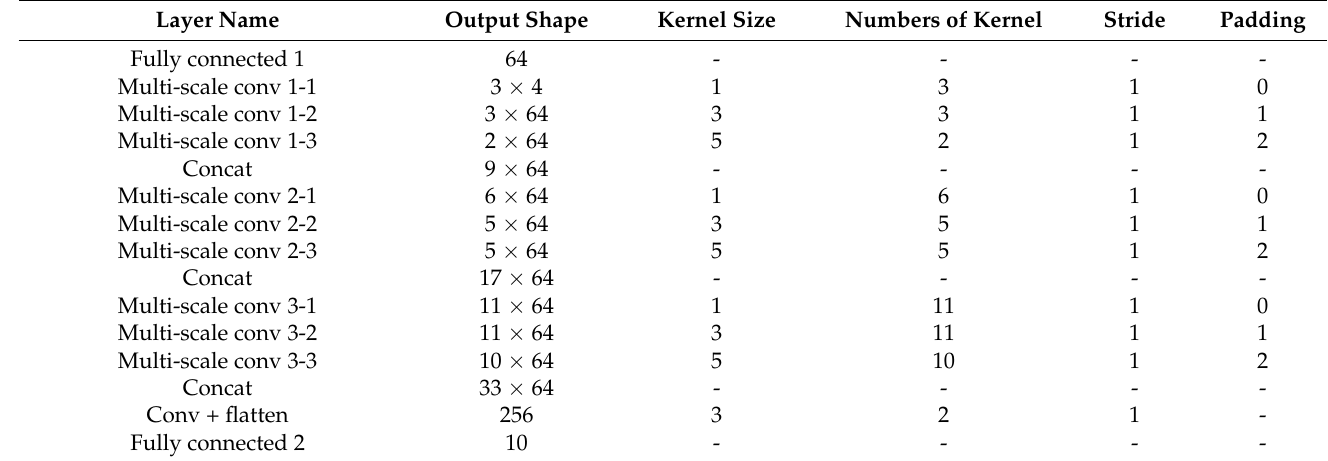
Table 1. Main parameters of multi-scale convolutional neural